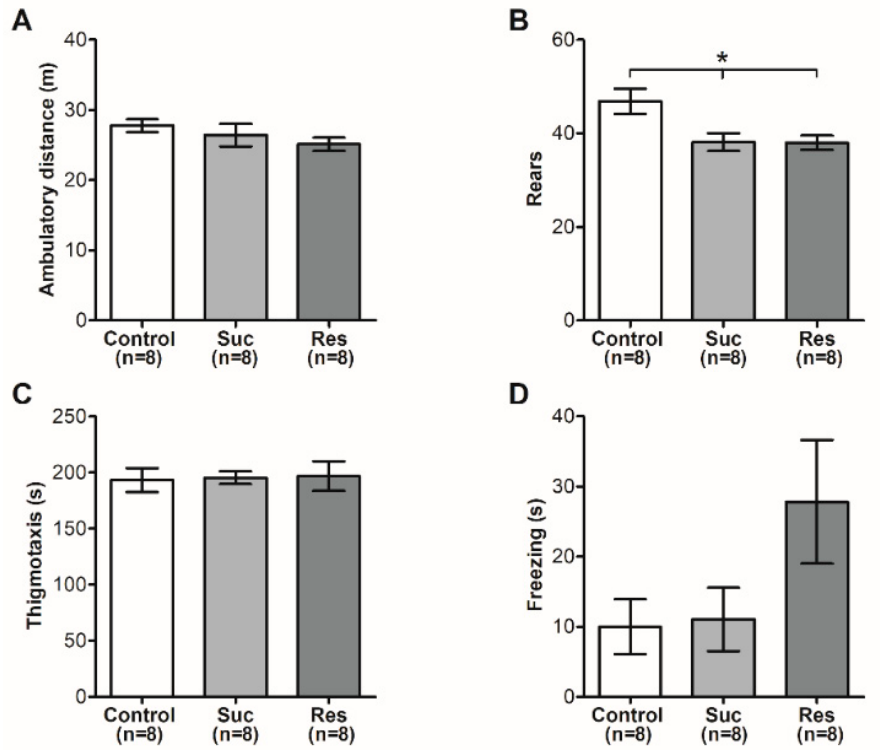
Figure 3. Sucrose consumption in late adolescence does not induce anxiety in the open field test. ( A ) Ambulatory distance traveled in the open field. ( B ) Number of rears in the arena. ( C ) Thigmotaxis or time traveled in the walls that enclose the area. ( D ) Time of immobility or freezing. These were analyzed via One-Way ANOVA followed by a Newman–Keuls test, * p < 0.05 vs. control.